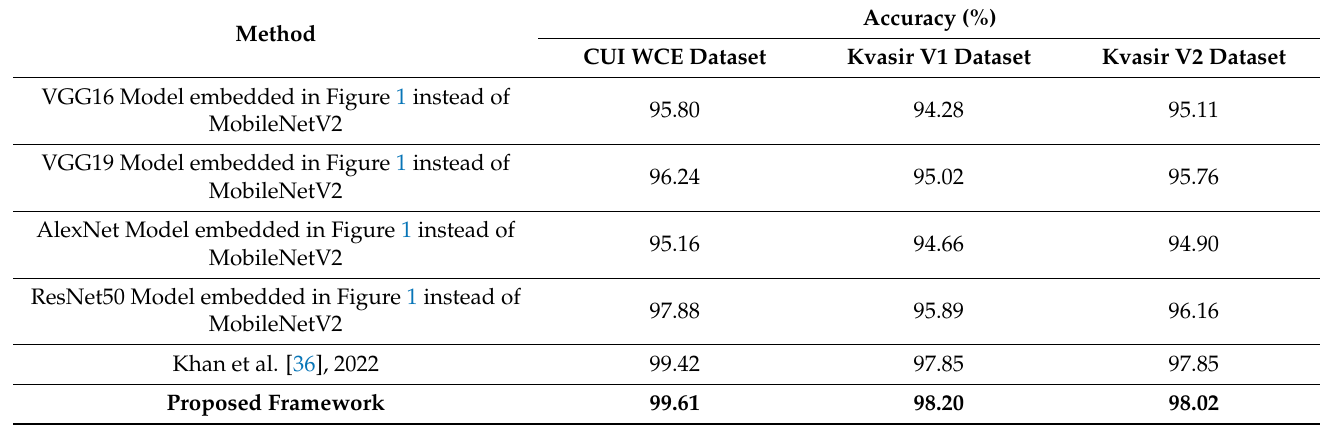
Table 4. Comparison of proposed framework with other neural nets using selected